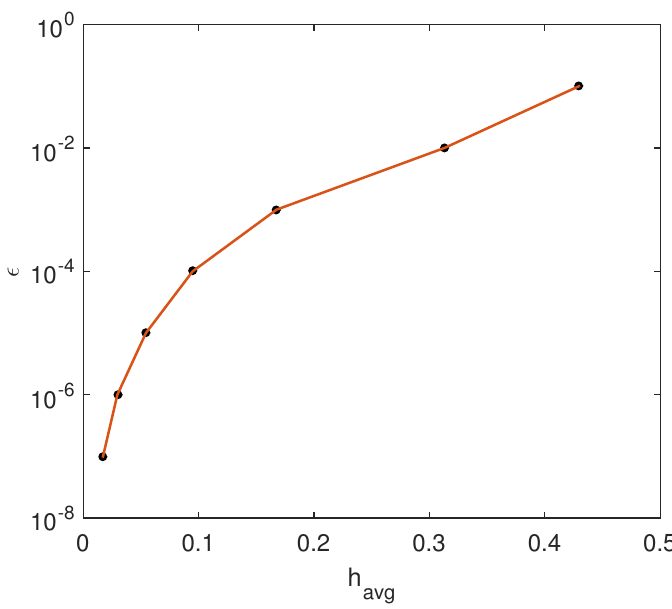
Figure 3. The accuracy as a function of the average time-step h avg